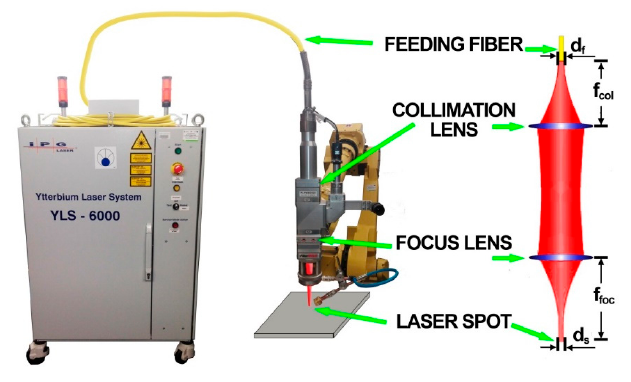
Figure 1. Experimental set-up for fiber laser welding [56].